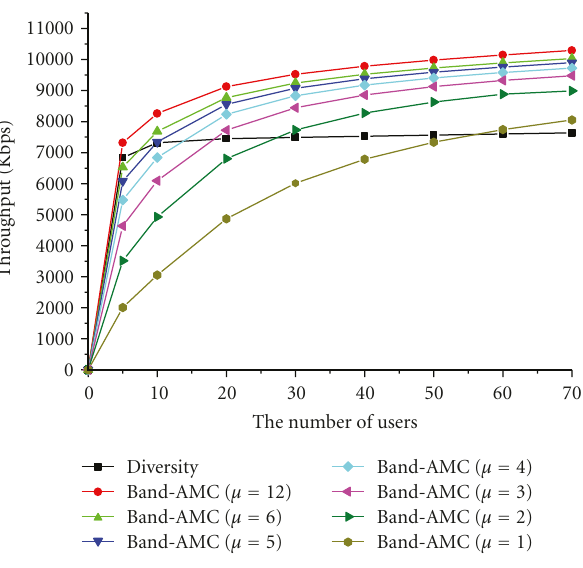
Figure 3: Average system throughput performance: L = 1 . Figure 4: Average system throughput performance: L = 3